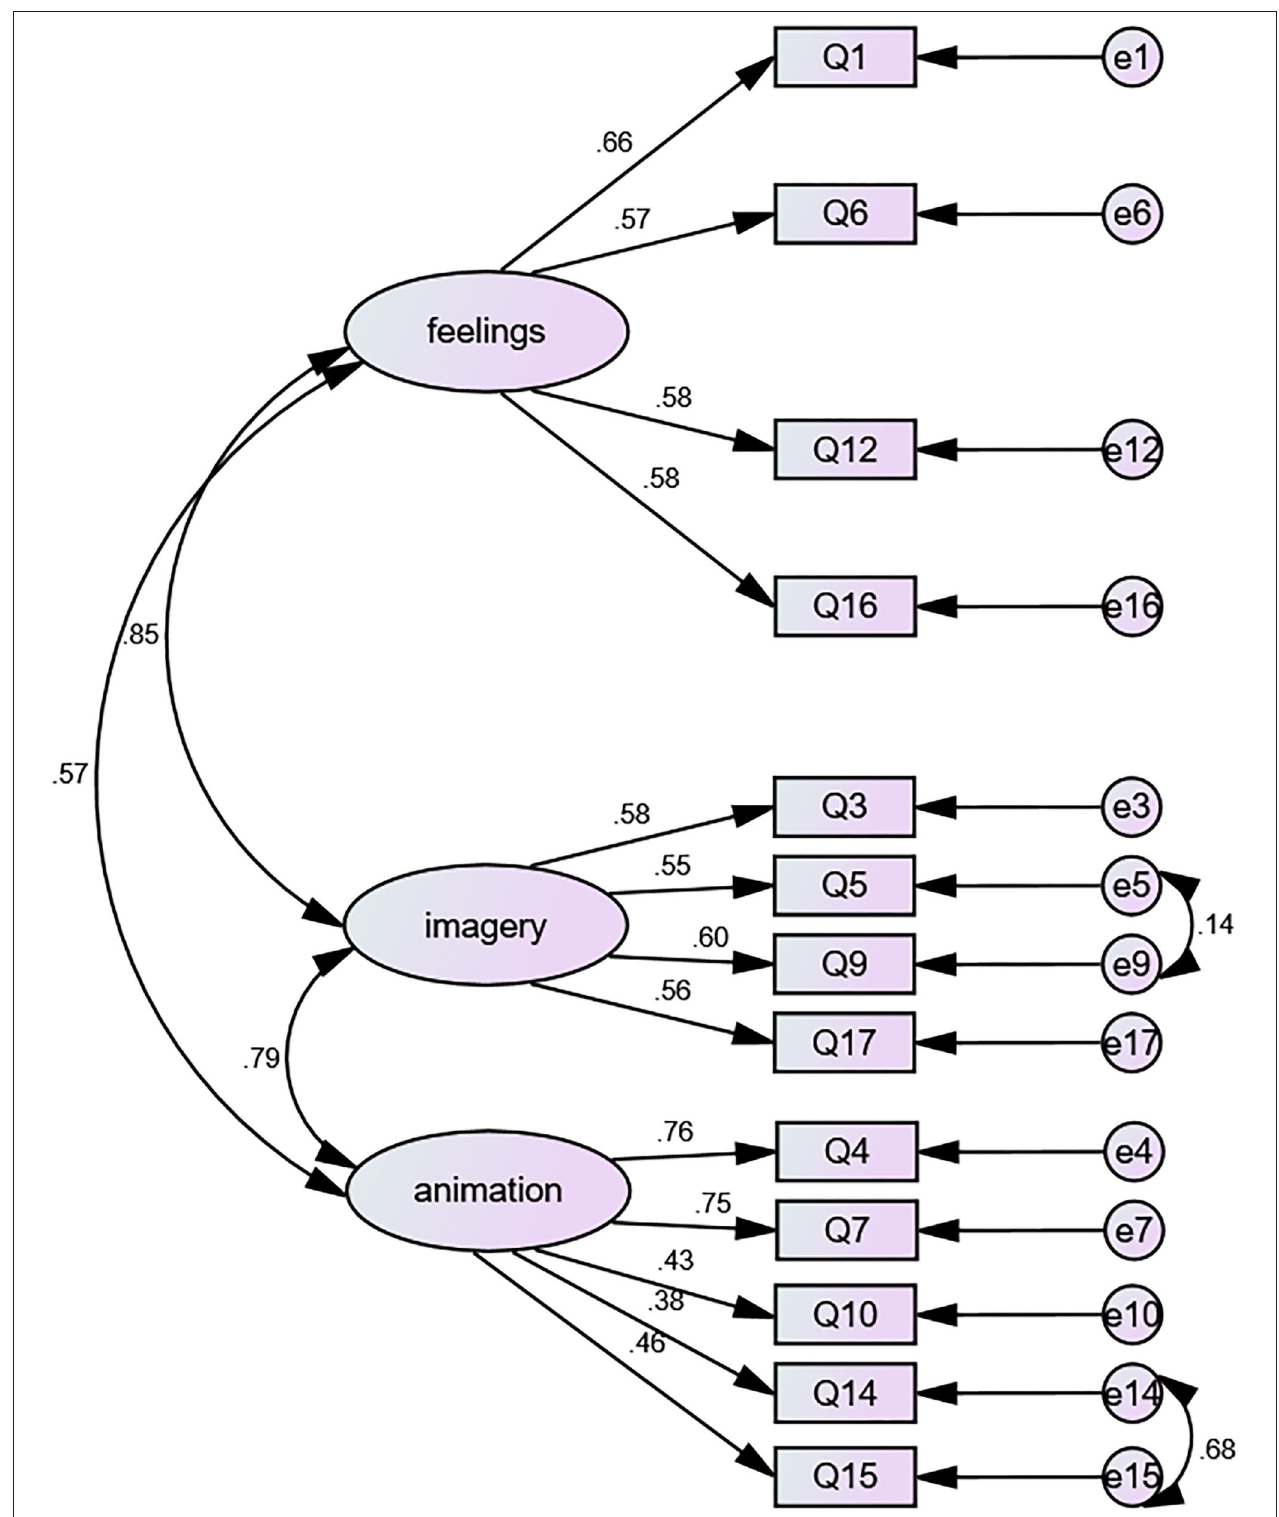
FIGURE 1 | Graphical representation of the 13-item Japanese Actions and Feelings Questionnaire (AFQ) 3 factor model with correlated error.